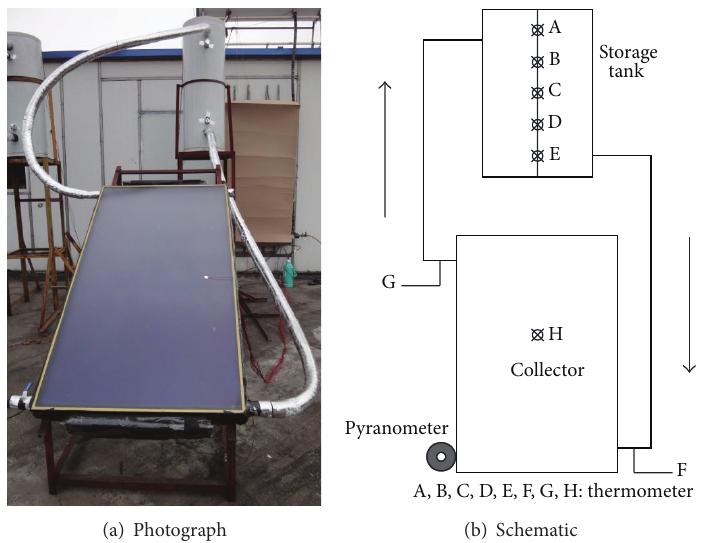
Figure 2: Configuration of the experimental setup of water heating test system.